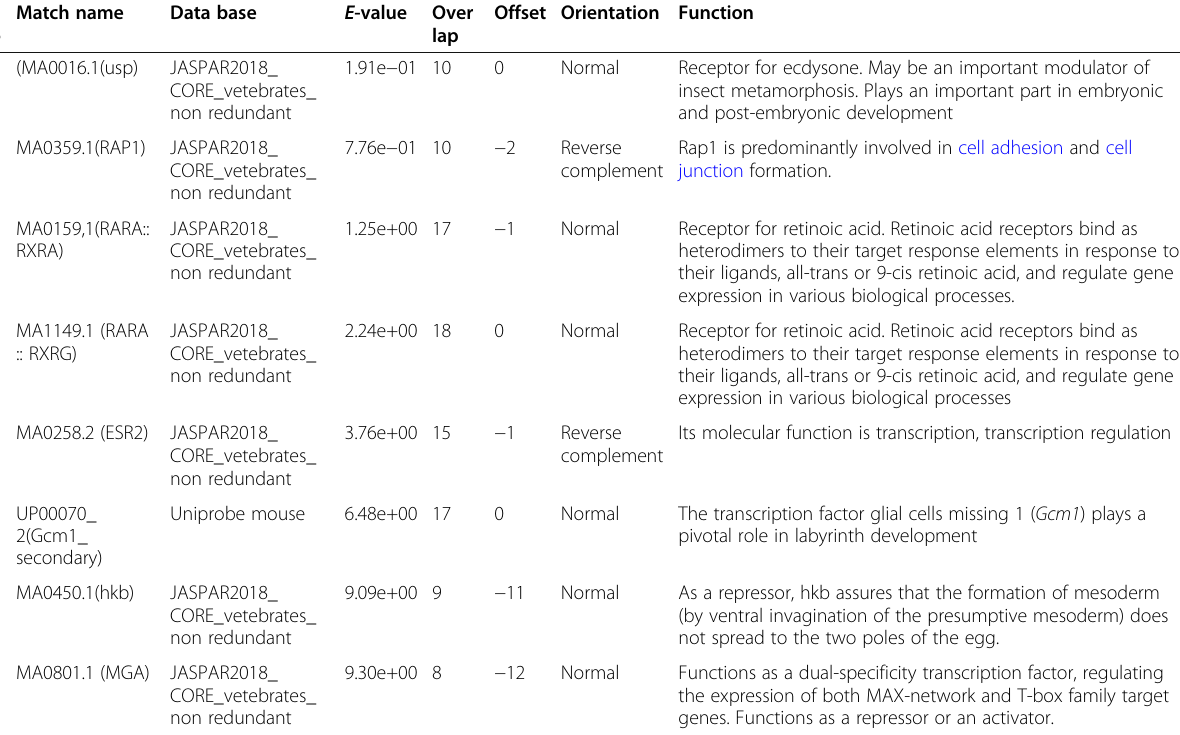
Table 4 List of matches to the query motif from the database JASPAR2018_CORE_vertebrates_non redundant and Uniprobe mouse